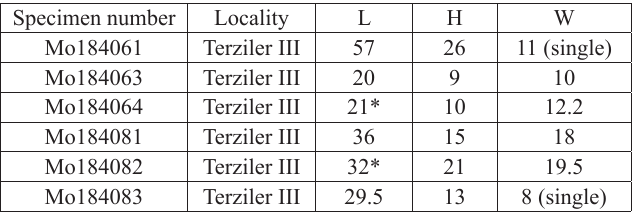
Table 2. Measurements (in mm) of Kasimlara kozuni sp. nov., * incom-